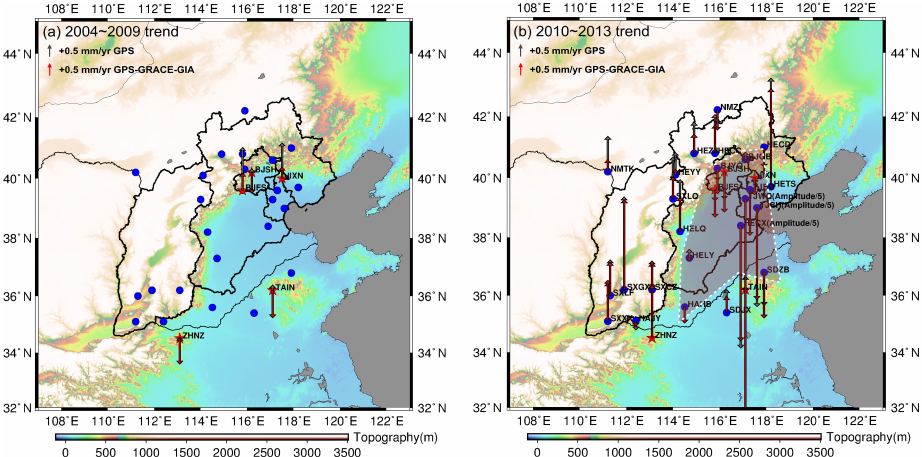
Figure 10. GPS (grey arrow, positive upward) and corrected GPS (red arrow, positive upward) vertical trend rate after subtracting the GRACE-derived long-term uplift rate due to load changes and GIA effect between 2004 and 2009 (a) , and between 2010 and 2013 (b)